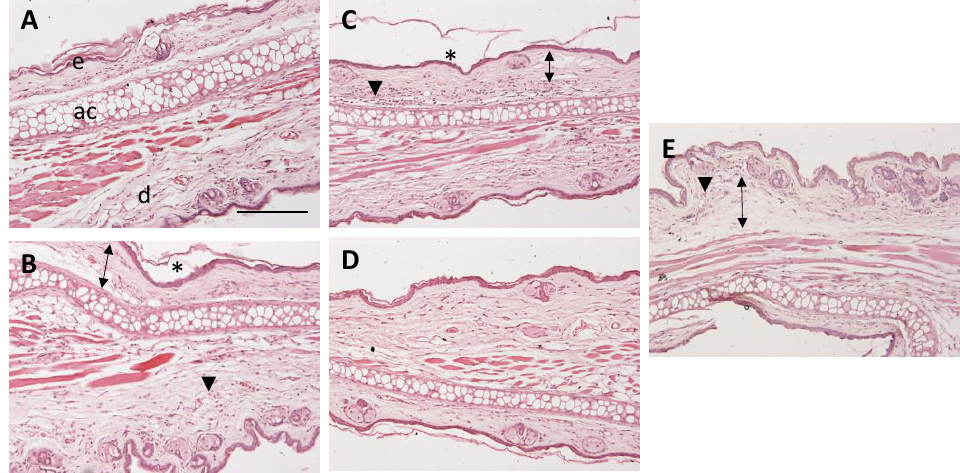
Figure 11. Representative micrographs of mice ear (100× magnification). ( A ) Negative control; ( B ) Positive control; ( C ) Ibuprofen; ( D ) Apremilast microemulsion (APR – ME); and ( E ) Blank – ME. Skin structures: ( e ) epidermis; ( d ) dermis; and ( ac ) auricular cartilage. Arrowheads indicate leukocytic infiltrates, arrows indicate edema, and asterisks ( ∗ ) indicate loss of stratum corneum. Scale bar = 200 µM.